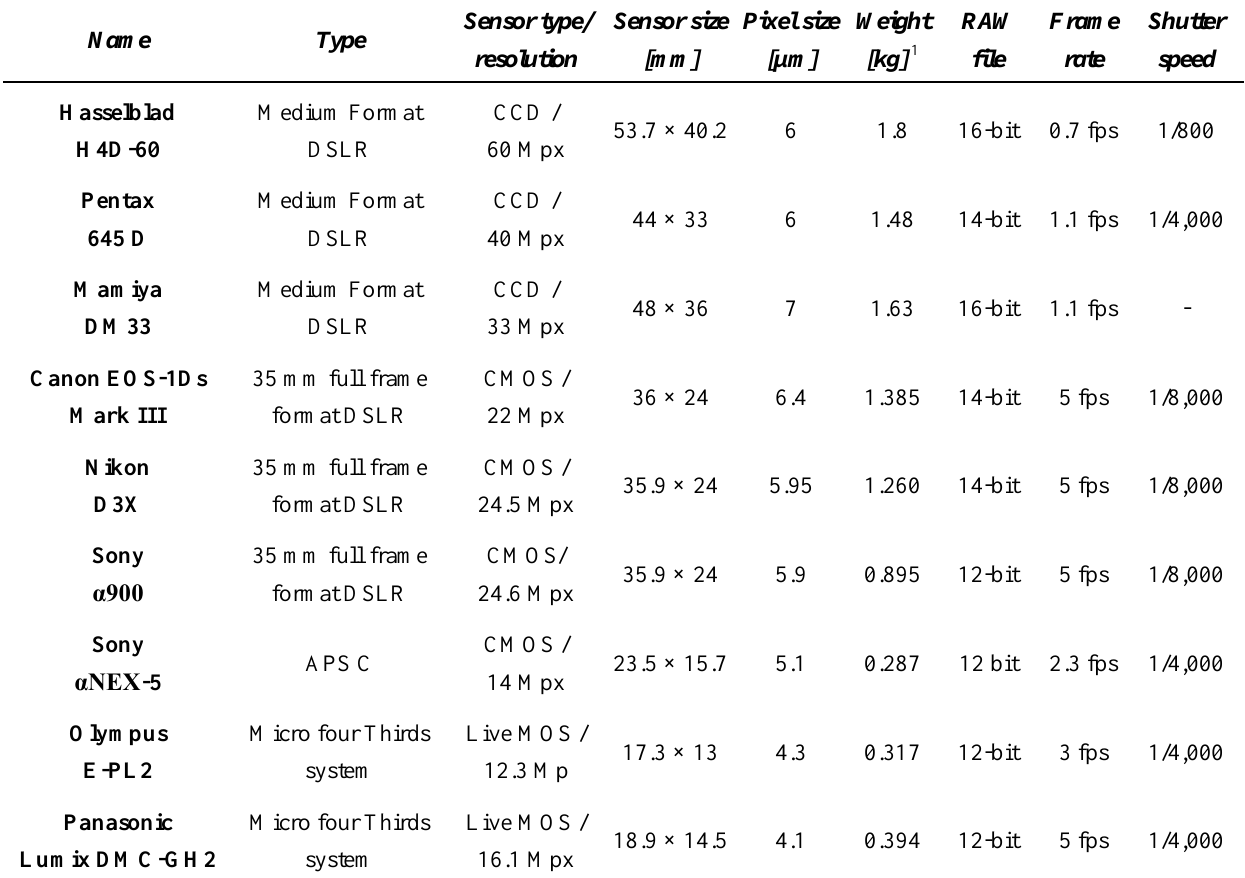
Table 5. Most common terrestrial digital cameras ( 1 weight without